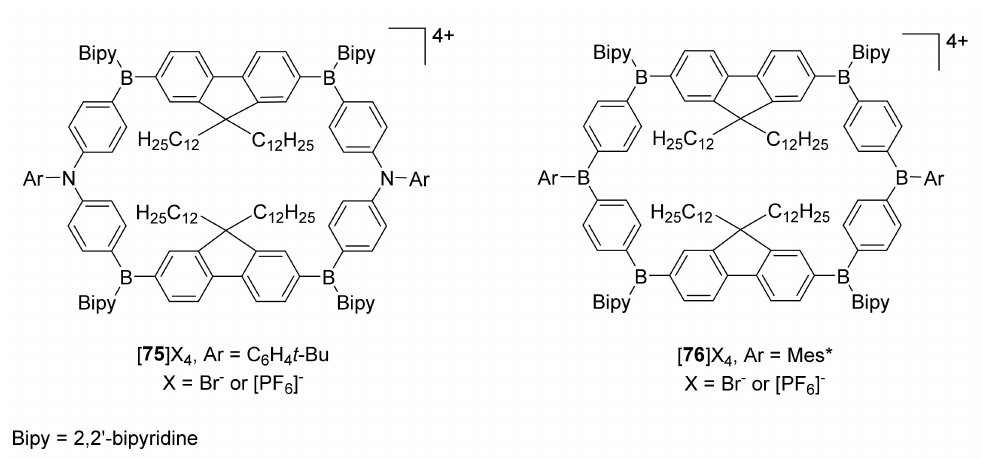
Figure 14. Structures of the polycationic organoboronium macrocycles 75 – 76 .